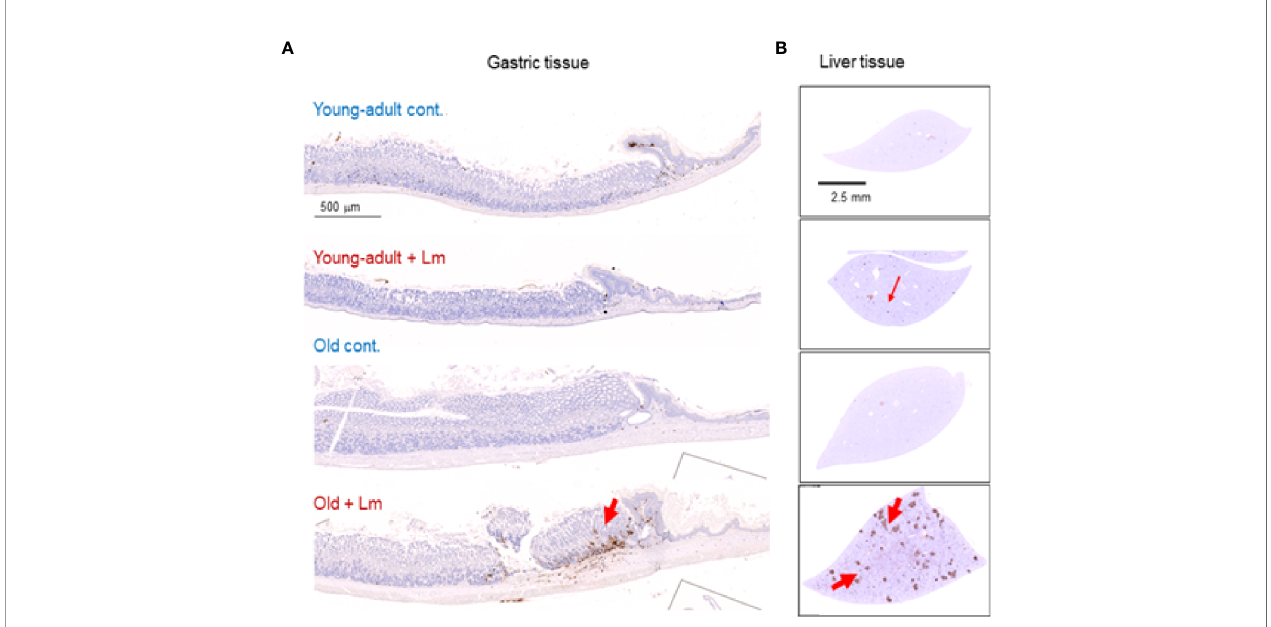
FIGURE 7 | Increased gastritis and liver in fl ammation in old mice as compared to young-adult mice after oral Listeria monocytogenes infection analyzed by immunohistochemical evaluation of gastrointestinal tissue by myeloperoxidase (MPO) staining (neutrophils). (A) Myeloperoxidase (MPO) (left column) gastric sections from representative control (uninfected) or infected young-adult mice (top two), and control (uninfected) or infected old mice (bottom two). Arrows denote cells expressing MPO. Only a few scattered mononuclear cell (MNCs) and MPO-positive granulocytes can be seen in the submucosa and lamina propria, with no abnormal thickening of the gastric wall noted in uninfected control mice. Severe gastritis with dense MNC in fi ltration and defused MPO-positive granulocytes were noted in the submucosa and mucosa of the old mice in the cardia region. MNC aggregates between the glands spanned the entire width of the mucosa. (B) Myeloperoxidase (MPO) (right column) liver sections from representative control (uninfected) or infected young-adult mice (top two), and control (uninfected) or infected old mice (bottom two). Arrows denote cells expressing MPO. Data from mean ± SEM from a representative experiment using 4 – 6